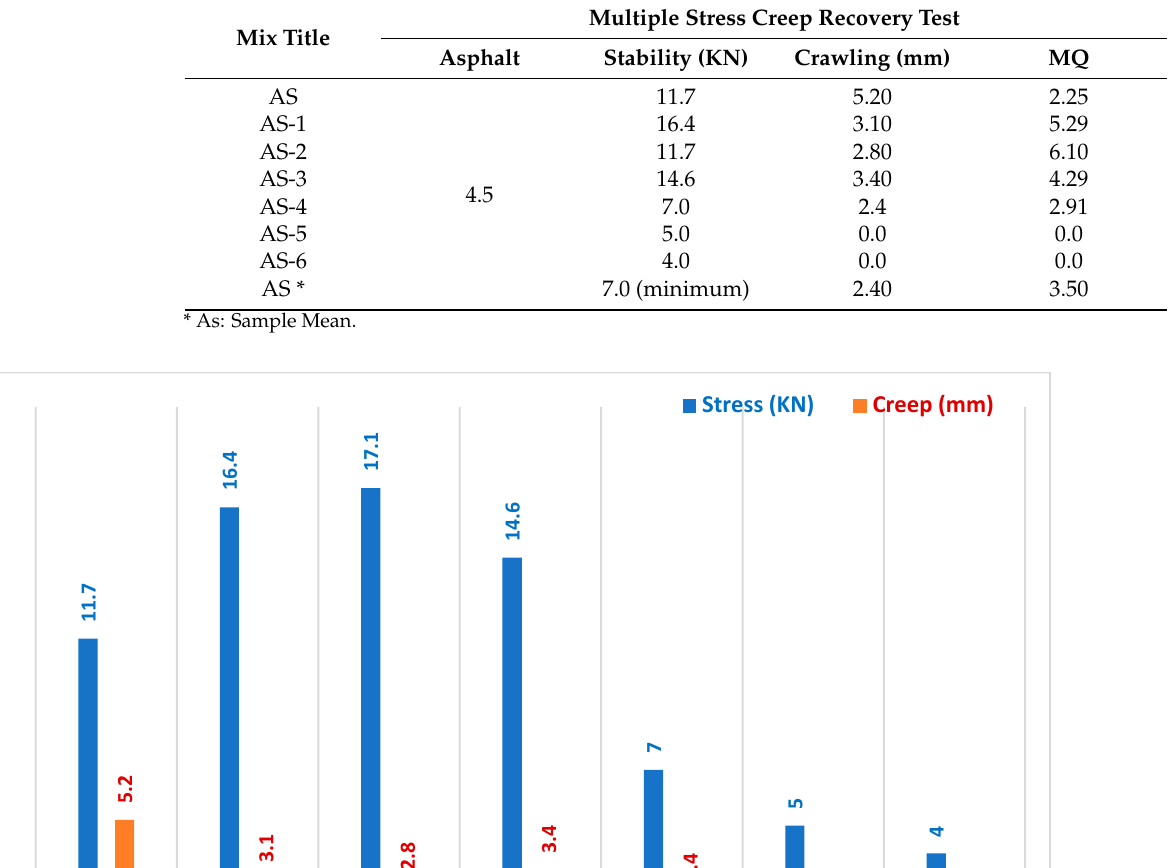
Table 7. Multiple stress and creep recovery of PW and ULO-modified asphalt pastes.